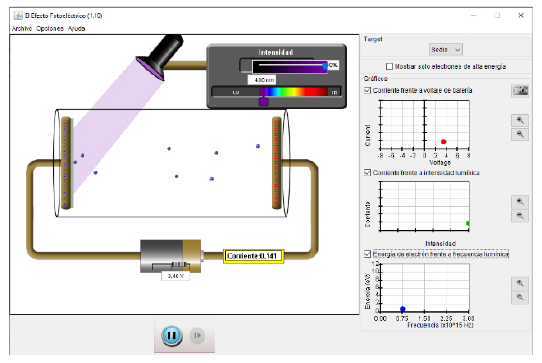
Fig. 9. Photoelectric effect